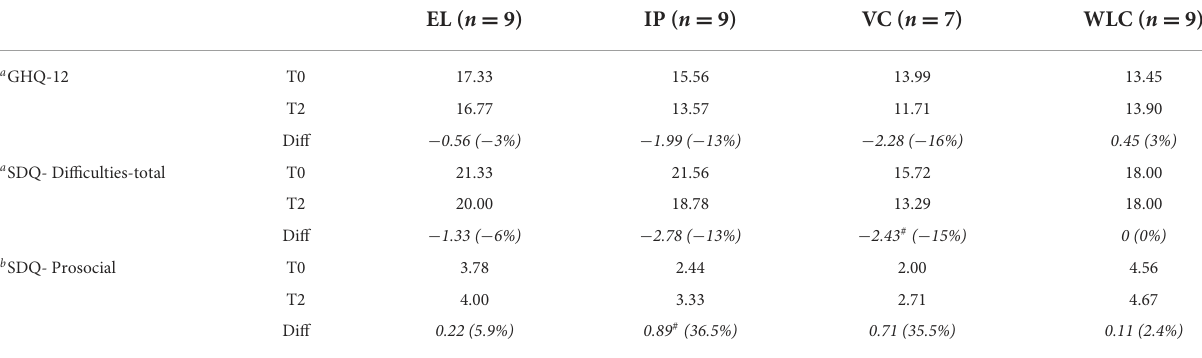
TABLE 8 GHQ-12 item and SDQ scores at T0 and